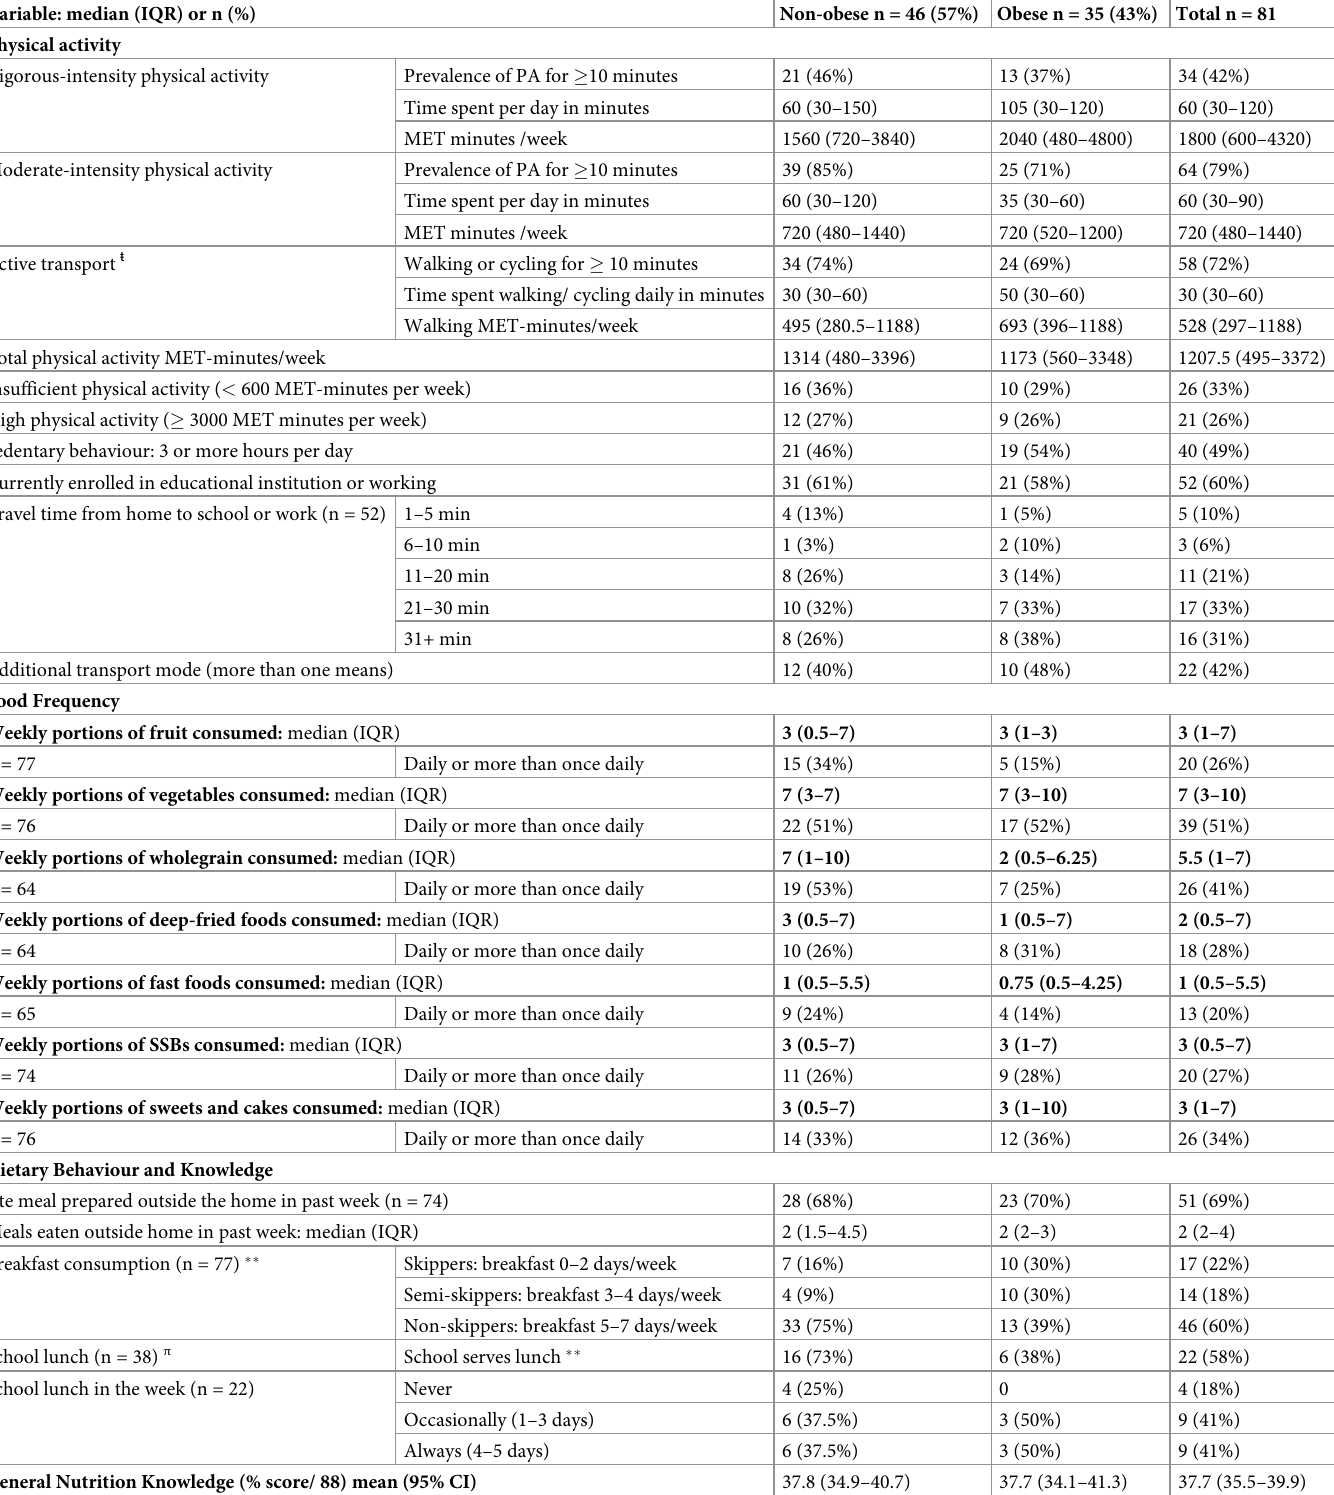
Table 2. Physical activity, dietary behaviour, and nutrition knowledge of AYLHIV by abdominal obesity status. Variable: median (IQR) or n